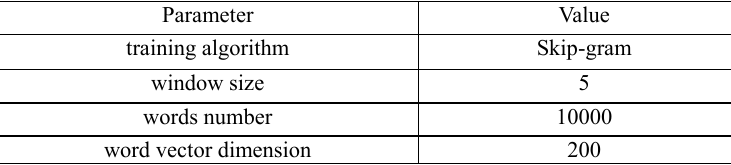
Table 1. Word2vec network parameters.